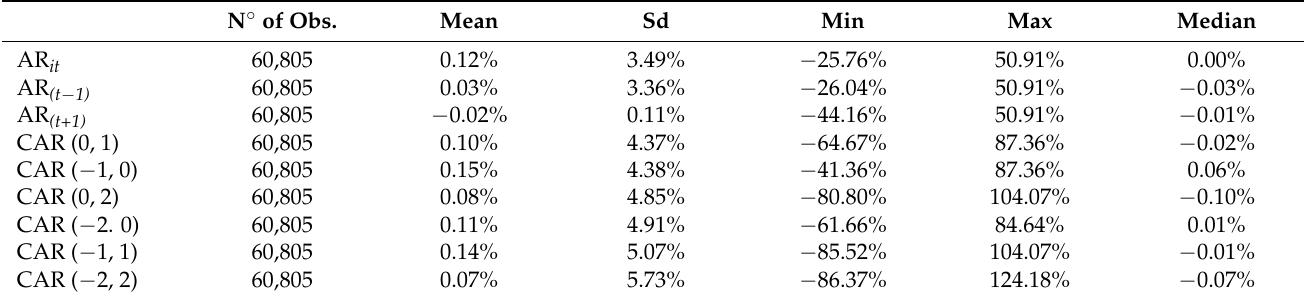
Table 2. Descriptive statistics of short-term ARs and CARs.